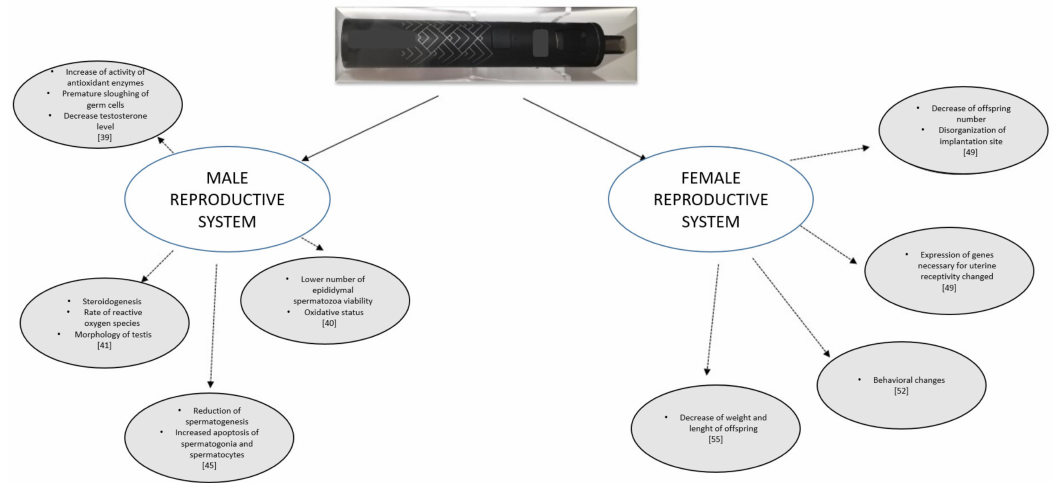
Figure 1. The influence of vapor components of e-cigarette on male and female reproductive system.